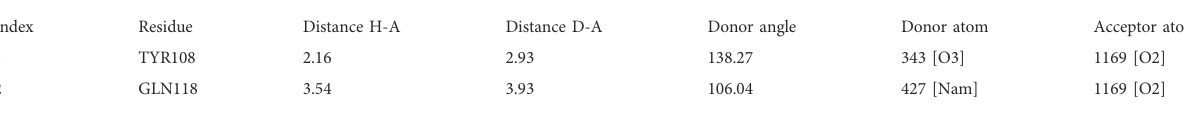
TABLE 3 The hydrogen bonds between Complex 5 and